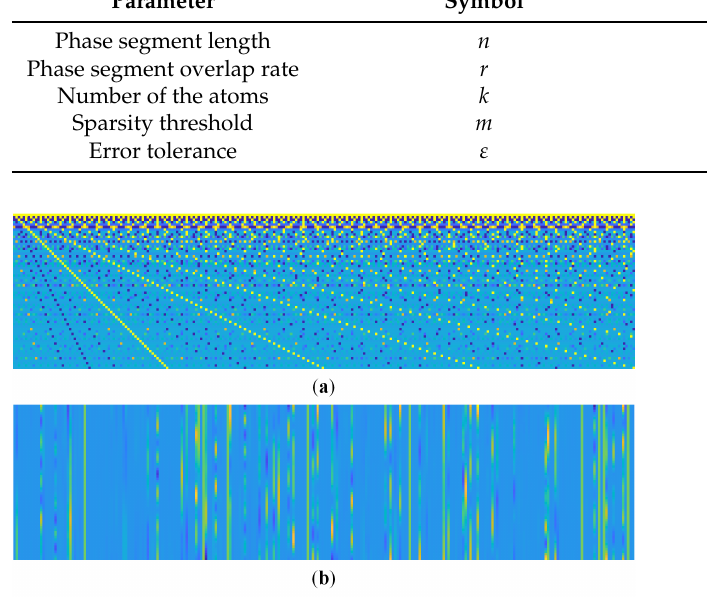
Figure 8. Matrix of the dictionary. ( a ) RS transform matrix. ( b ) Trained sparse